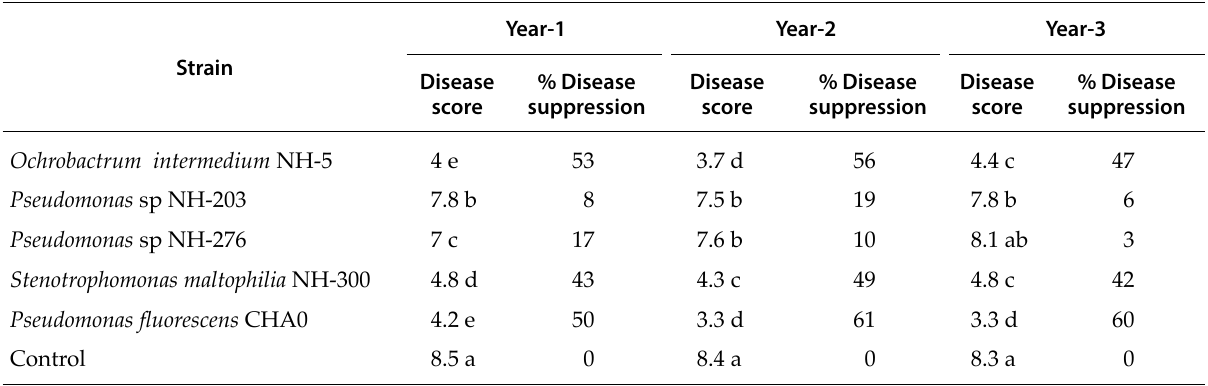
Table 5. Effects of the antagonistic bacteria on the incidence of red rot (caused by Colletotrichum falcatum ) on sugarcane in “stalk inoculation” experiments.